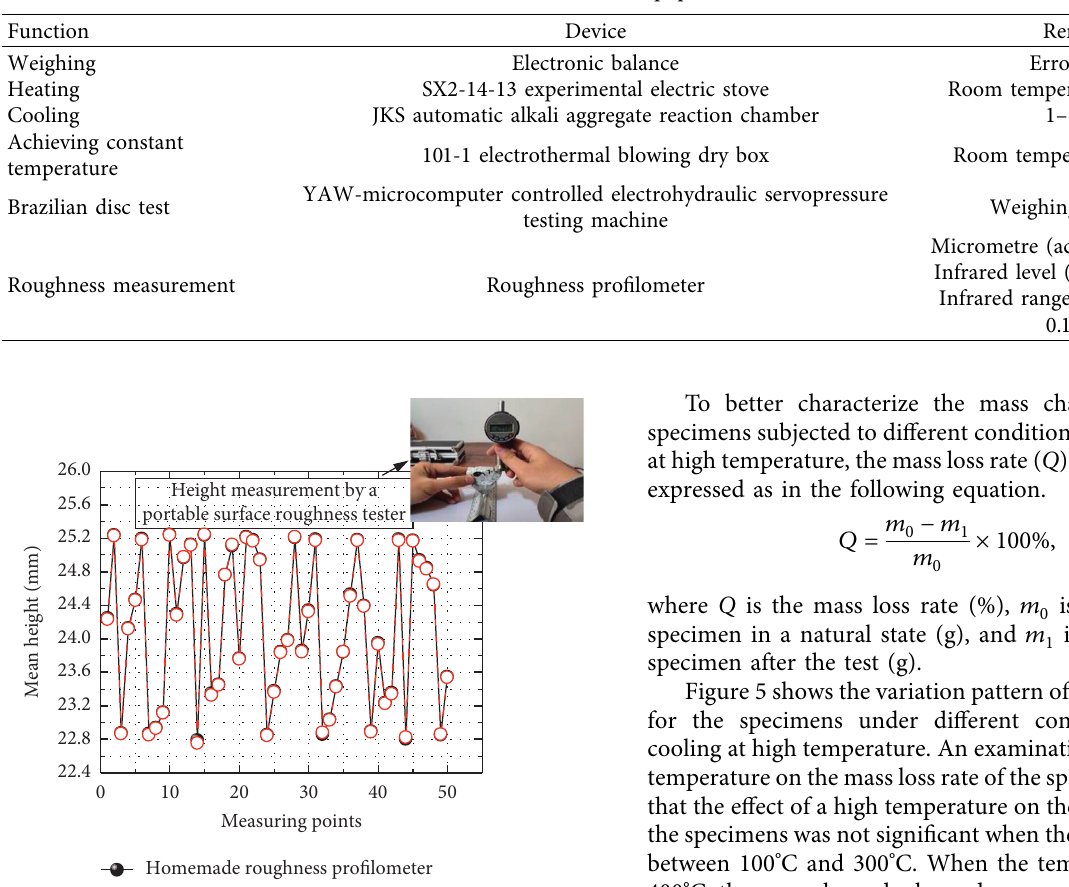
Table 3: Test equipment.